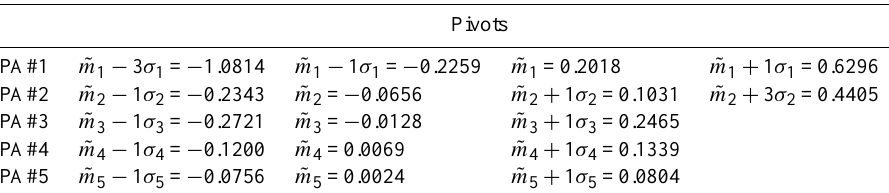
Table 3. Coordinates of the pivots along the five first principal axes. The median ˜ m i and the standard deviation σ i of each distribution ( i =1, ..., 5) were used to compute the pivots. They were chosen such as to span the spectrum with a reduced number of points. See Fig. 5 for a representation of the PC spectrum.